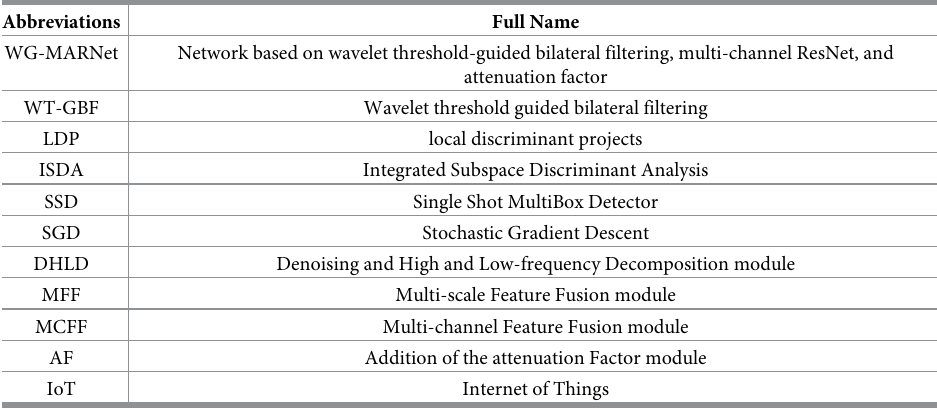
Table 1. Abbreviations appearing in this